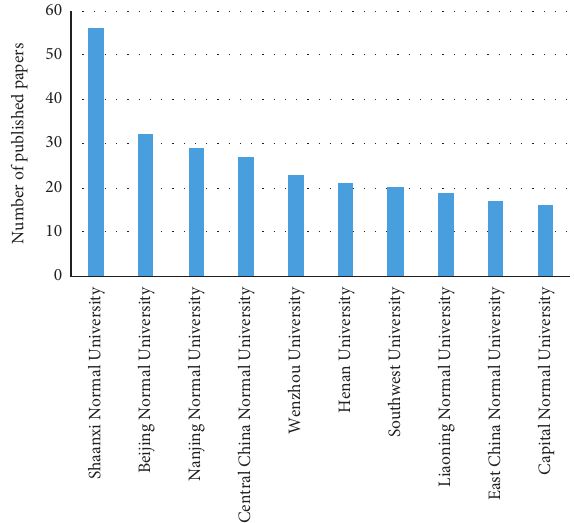
Figure 2: Papers published by high-yield